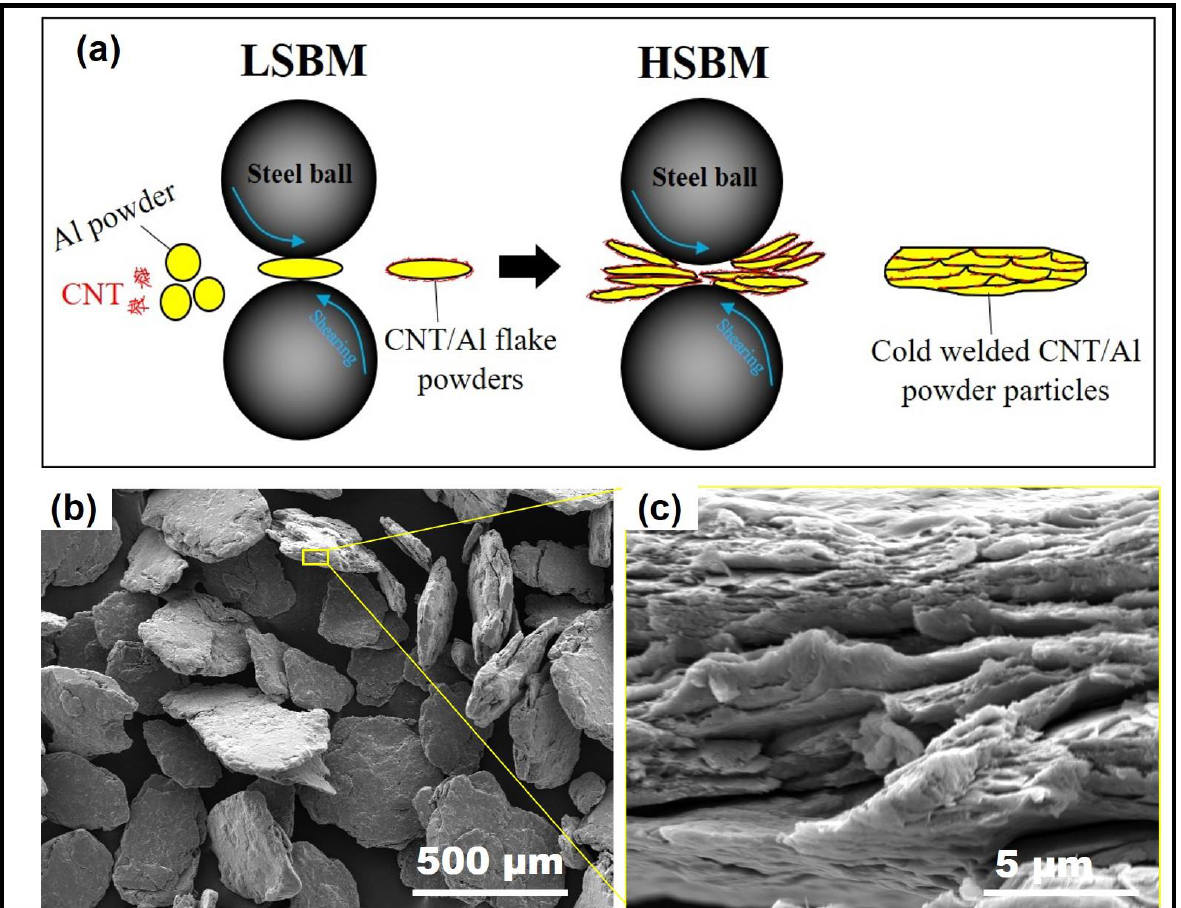
Figure 4. ( a ) Illustration of co-deformation/dispersion mechanisms of CNT/Al powders during FPM-SSBM, ( b , c ) SEM images of CNT/Al particles obtained via FPM-SSBM route.